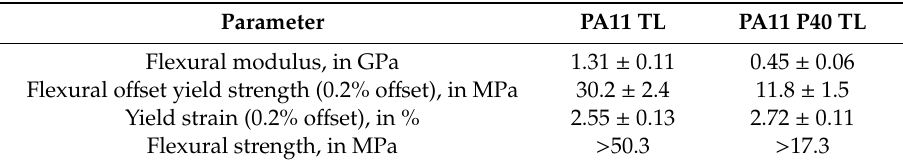
Table 3. Flexural parameters of PA11